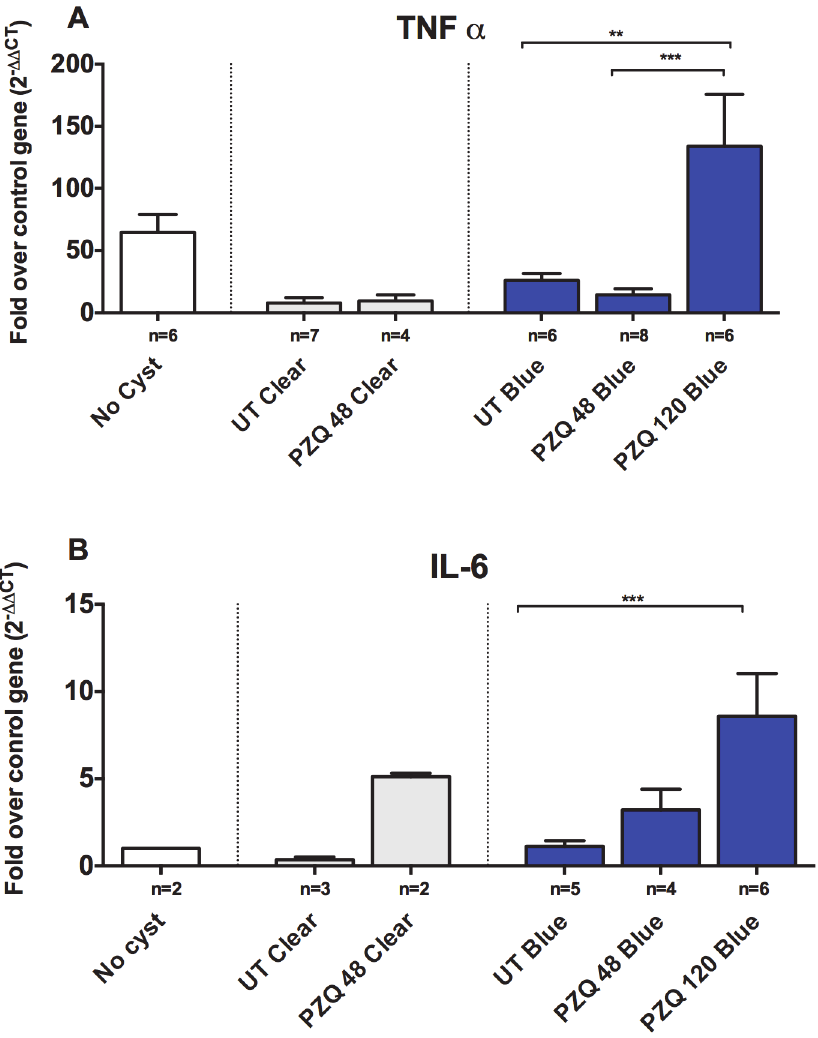
Fig 3. Upregulation of proinflammatory genes in EB capsules compared to clear capsules. Expression levels of RNA in six types of brain tissue samples, uninfected brain tissue distant from cysts (no cysts), clear pericystic brain tissue in untreated pigs (UT Clear) and at 48h post treatment (PZQ 48 Clear) and EB capsules in untreated pigs (UT Blue) and at 48h (PZQ 48 h Blue) and 120h post treatment (PZQ 120 h Blue) were quantified using real-time reverse transcriptase polymerase chain reaction (RT-PCR) assays. Gene expression levels are depicted as fold increase of studied RNA over reference (housekeeping) RNA (18S rRNA), TNF- α (A; number [n] of samples for the indicated types of capsules are shown below each bar) and IL-6 (B). The bars represent means and CI 95 for the group. Statistically significant differences in levels of gene expression are indicated by asterisks (p < 0.05, Mann-Whitney U test). Asterisks represent level of significance: * : p < 0.05; ** : p < 0.01; *** : p <